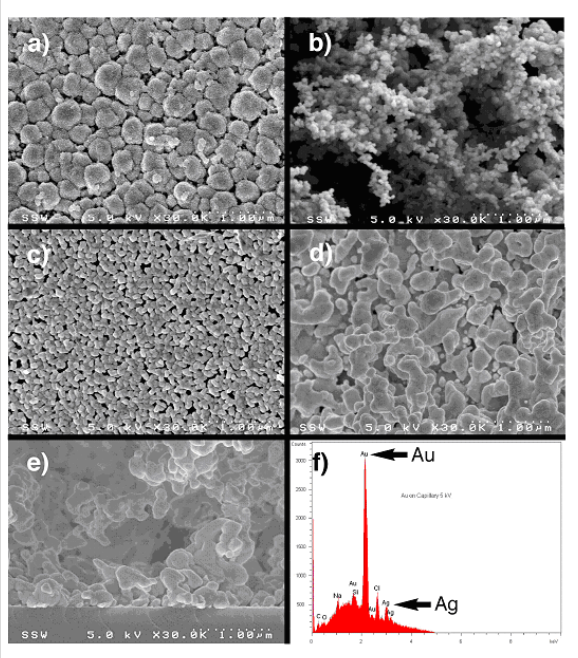
Figure 2: X-ray analysis of the metal films used in this benzannulation study. Panels a–e are scanning-electron micrographs (SEM) of all films taken at 30,000 × magnification: a) Cu, b) Pd, c) Ag, d) Au layered on a base film of Ag. Panel e shows the side view of the Au film attached to the glass capillary wall (bottom of image), between which is sandwiched a barely-visible thin Ag coating. Panel f is the energy-dispersive X-ray (EDX) spectrum of the Au film from panel d; note the small level of Ag that is present that helps to anchor the Au to the surface of the